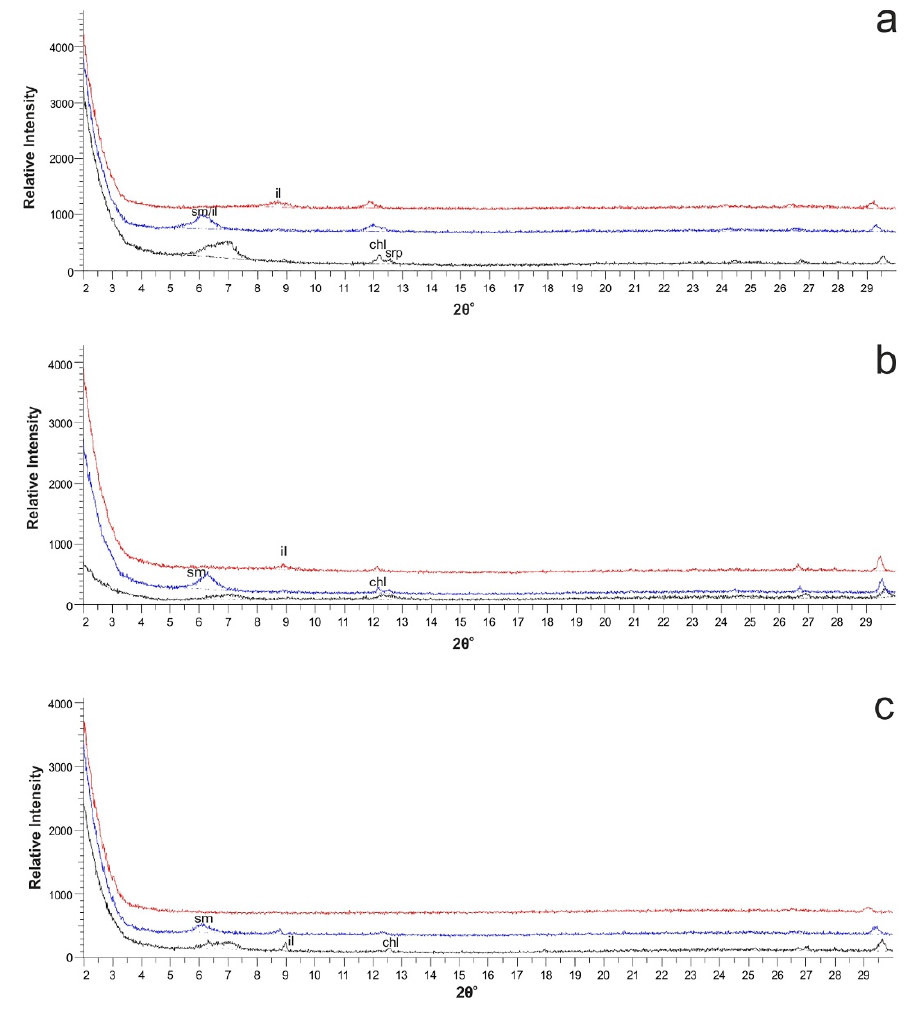
Figure 4. X-ray diffractograms of the clay fraction of representative examined samples: ( a ) Pentalofos Formation sample, ( b ) Northern Eptachori Formation sample, ( c ) Southern Eptachori Formation sample. (Black pattern: air dried; blue pattern: glycolated; red pattern: heated).